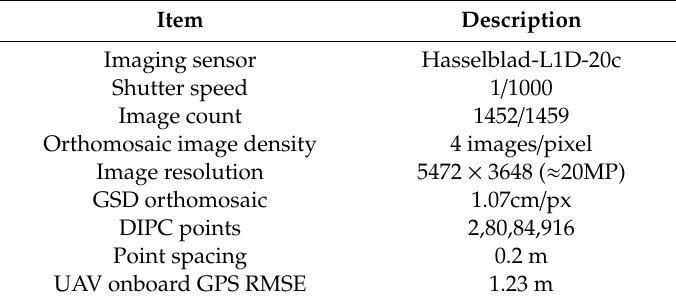
Table 1. A detail description of acquired images and DIPC.